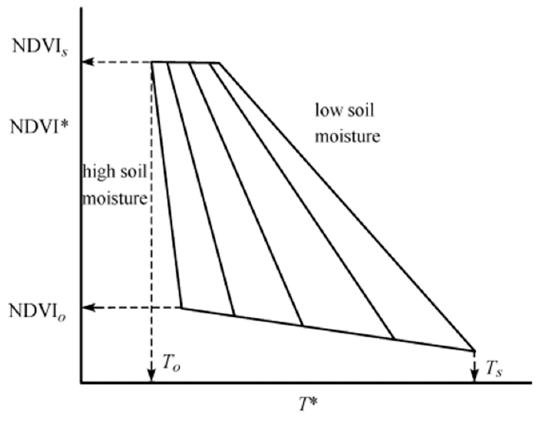
Figure 3. Universal triangle relationship between soil moisture, temperature, and the normalized difference vegetation index (NDVI) [30].